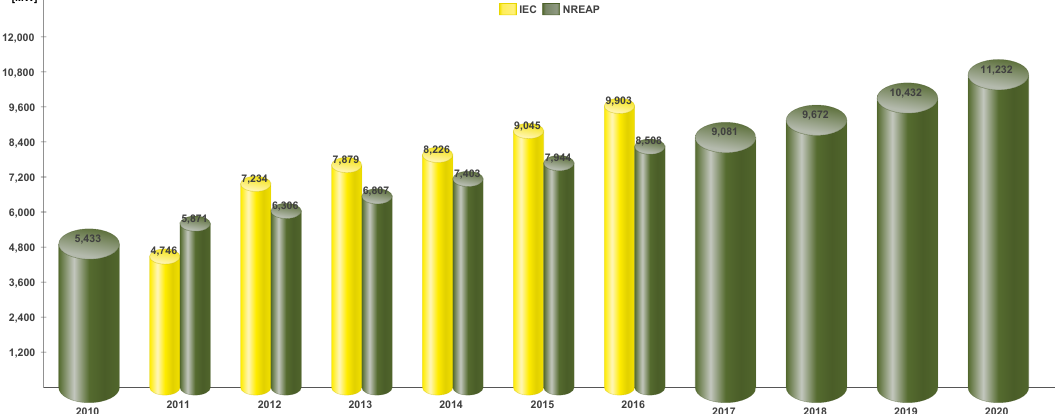
Figure 5. Total installed electricity capacity at EU28 level combined with National Renewable Energy Action Plan (NREAP) yearly targets. Data from: Reference